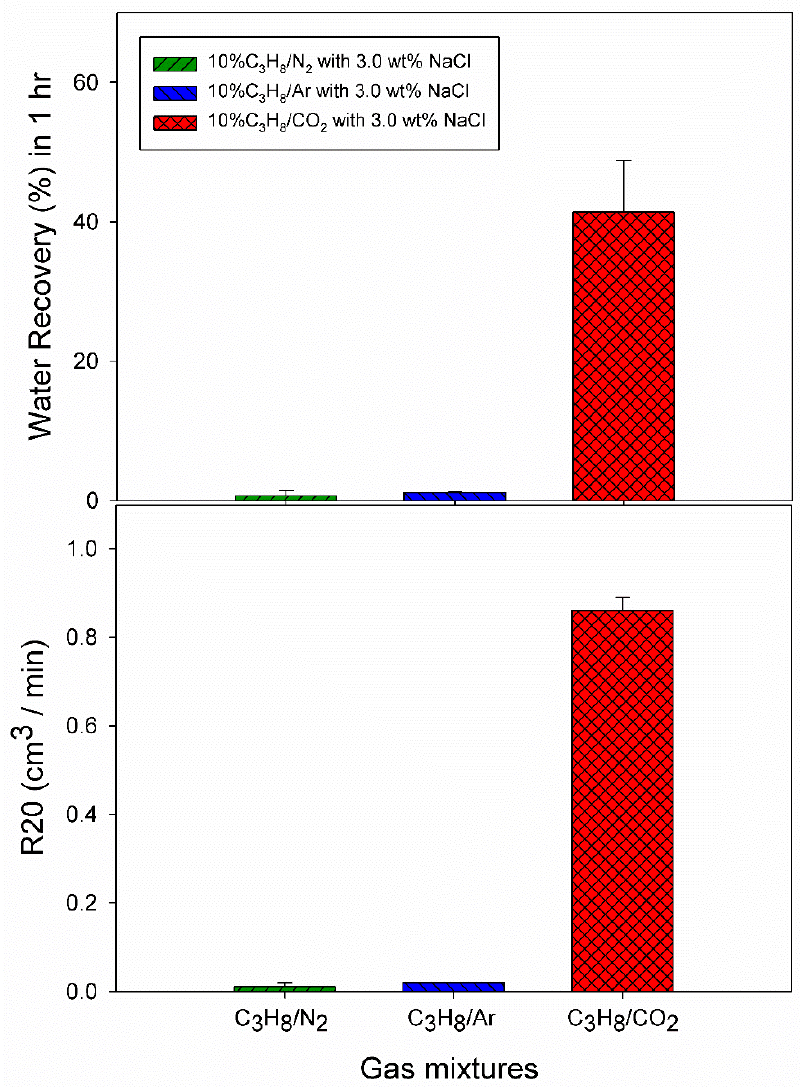
Figure 9. Comparison of water recovery with different gas mixtures and 3.0 wt% NaCl aqueous solution.